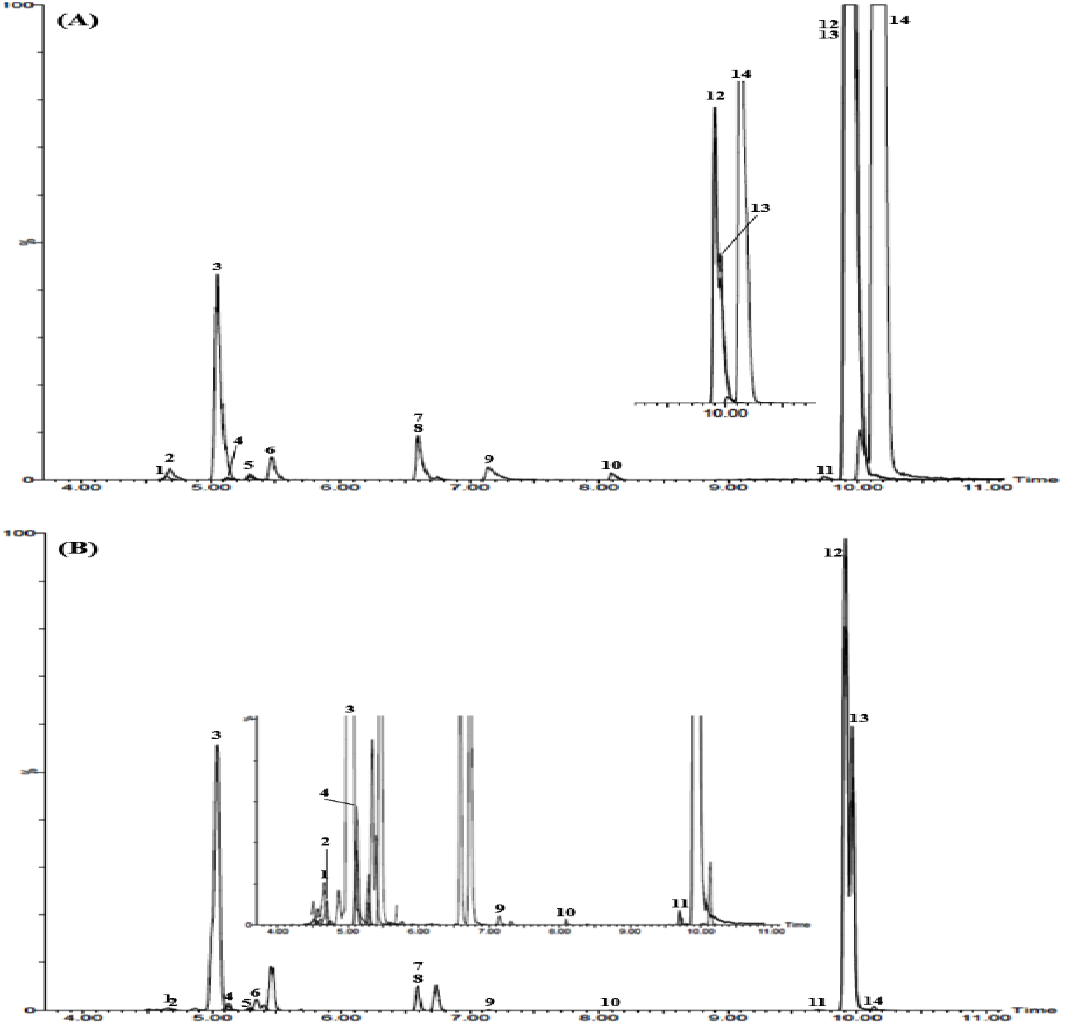
Figure 2. Total ion chromatograms of ( A ) the 14 reference standard solutions and ( B ) SDGT extract by LC–MS/MS MRM mode. (1) LIQA, (2) LIQ, (3) NOD, (4) NAR, (5) NARG, (6) HES, (7) NPON, (8) PON, (9) API, (10) GLY, (11) HON, (12) DEC, (13) DECA, and (14) PRAA.